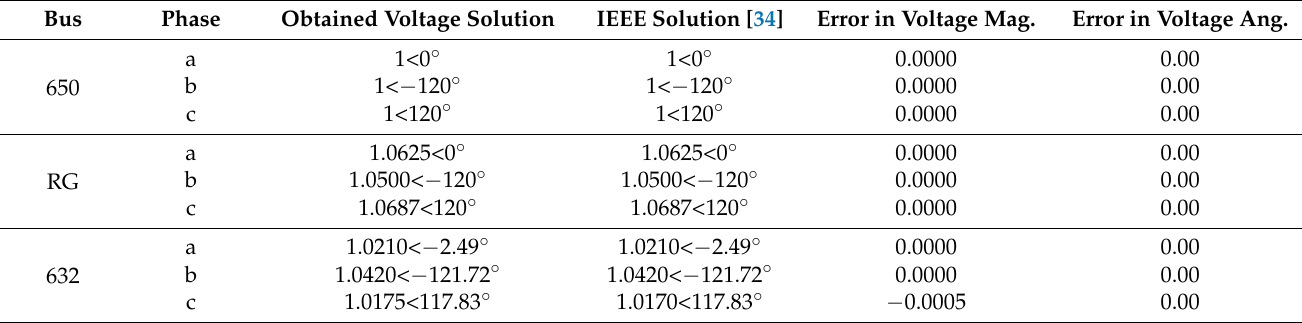
Table 5. Comparison of power flow solution with the IEEE solution for the IEEE-13 bus